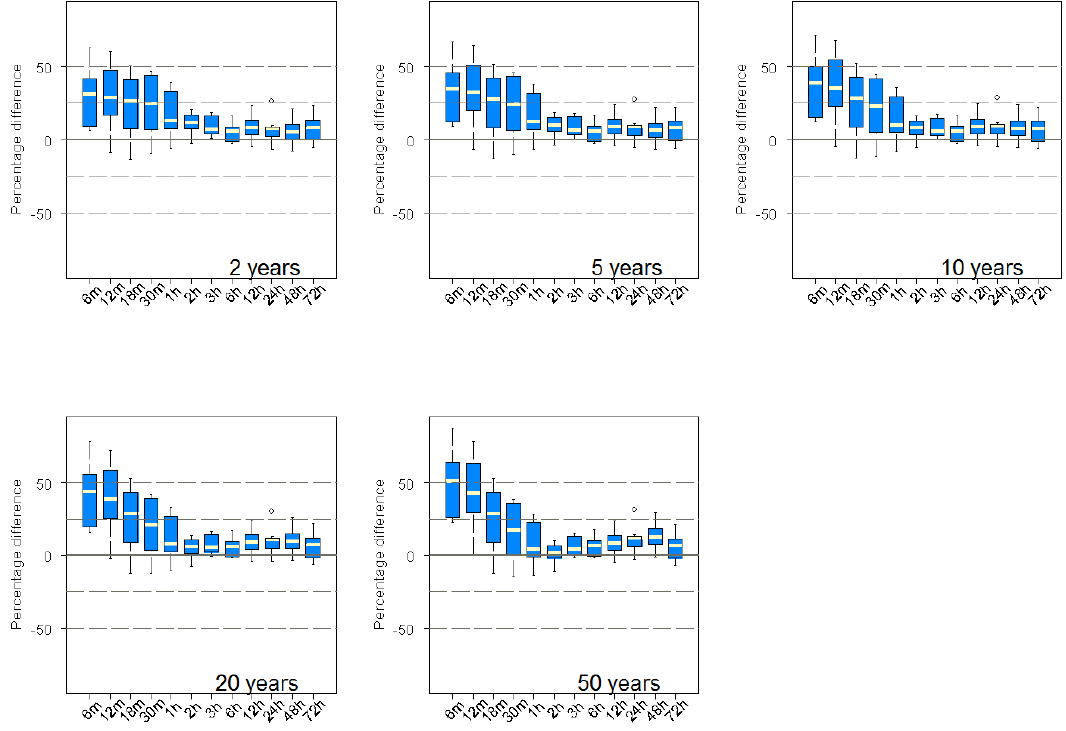
Fig. 5. As Fig. 4 but for the south cluster. Positive values indicate an increase from the earlier to the later